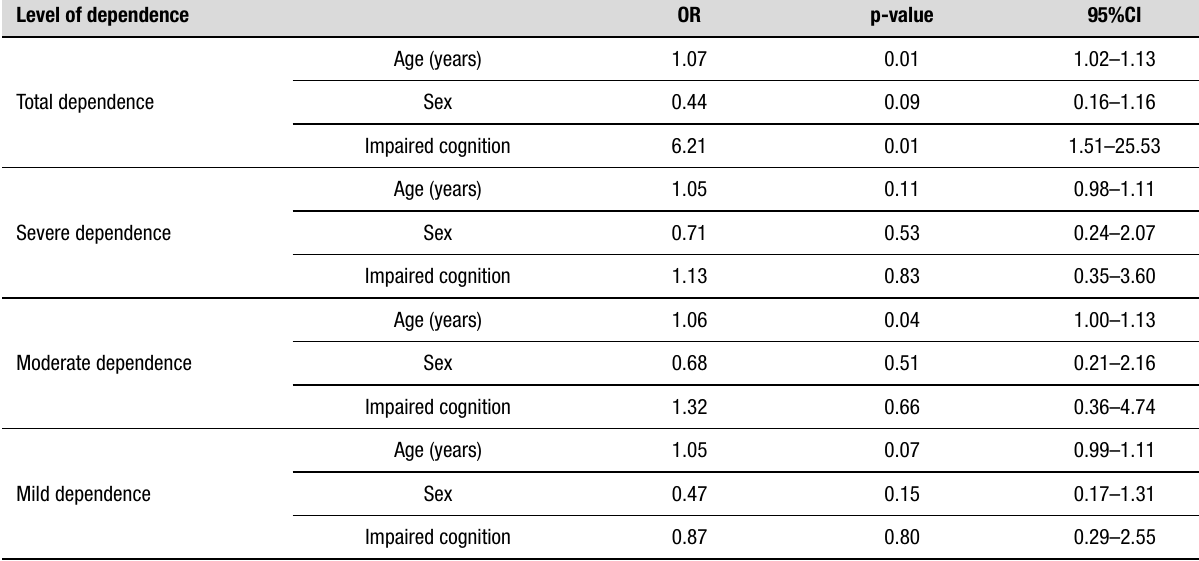
Table 3. Association between functional dependence and impaired cognition. Level of